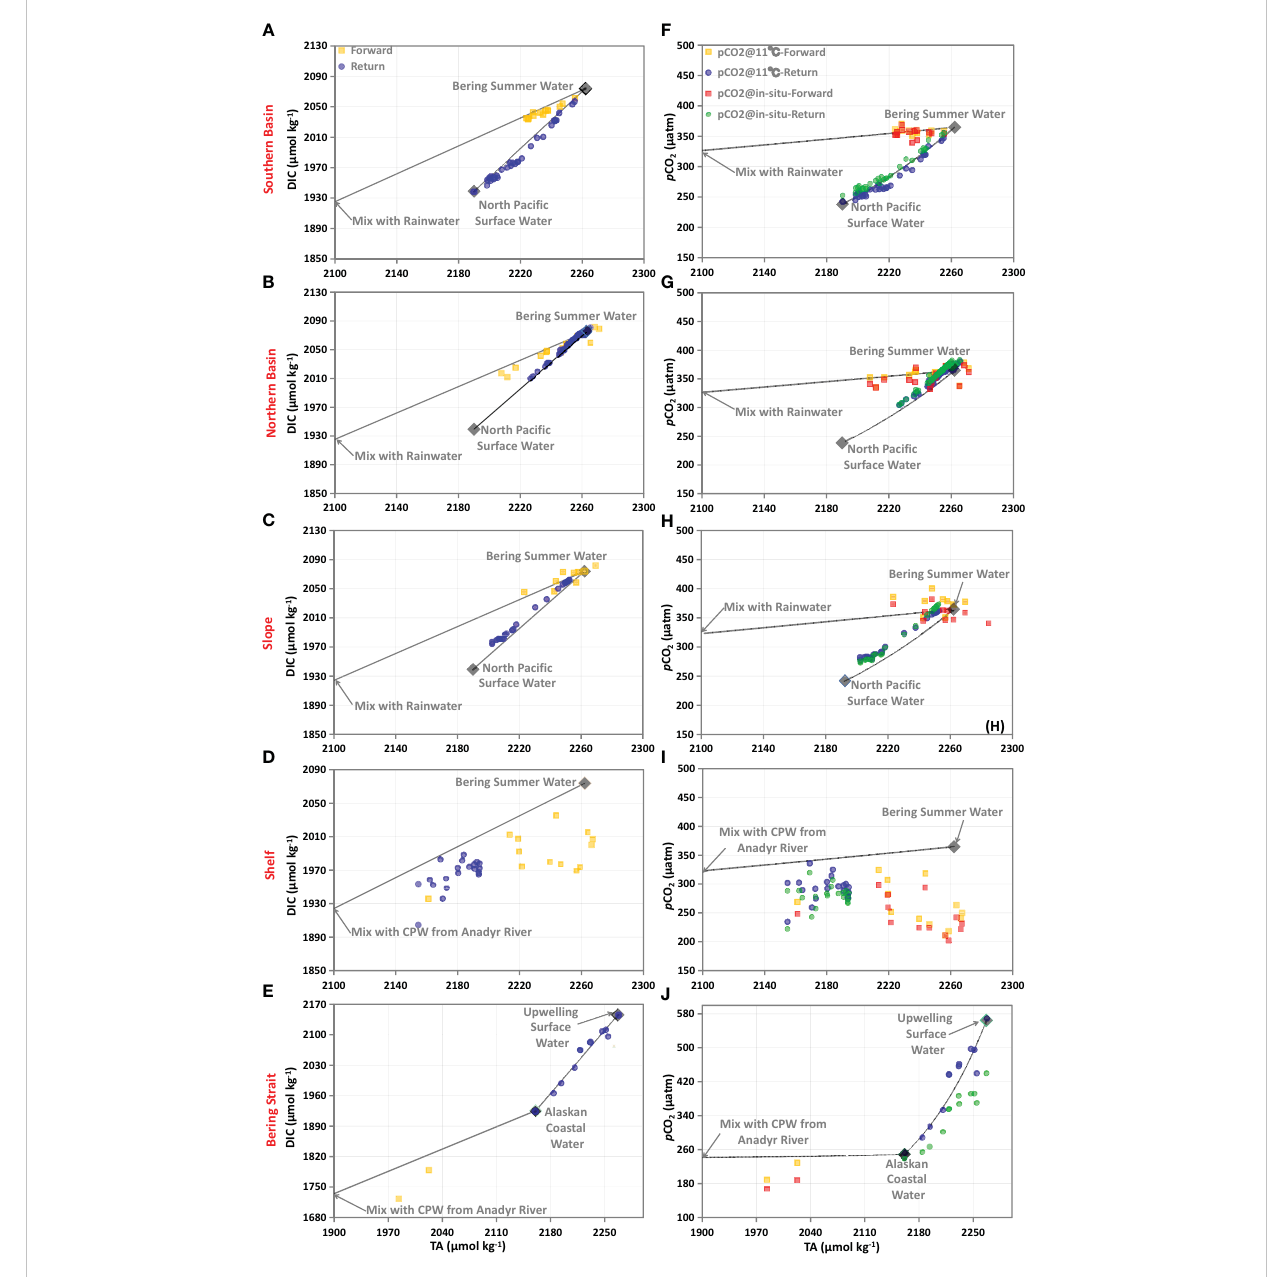
FIGURE 6 DIC-TA (left column) and p CO 2 -TA (right column) relationships in the Southern Basin (A, F) , the Northern Basin (B, G) , the Slope (C, H) , the Shelf (D, I) , and the Bering Strait (E, J) during both voyages. In all panels, gray diamonds are end-members, and their values are summarized in Table 2. Solid lines represent the hypothetical conservative mixing lines between different end-members. p CO 2@11°C represents p CO 2 normalized to 11 °C, following Wanninkhof et al. (2022), and 11 °C is the average SST in the Bering Sea Basin during both